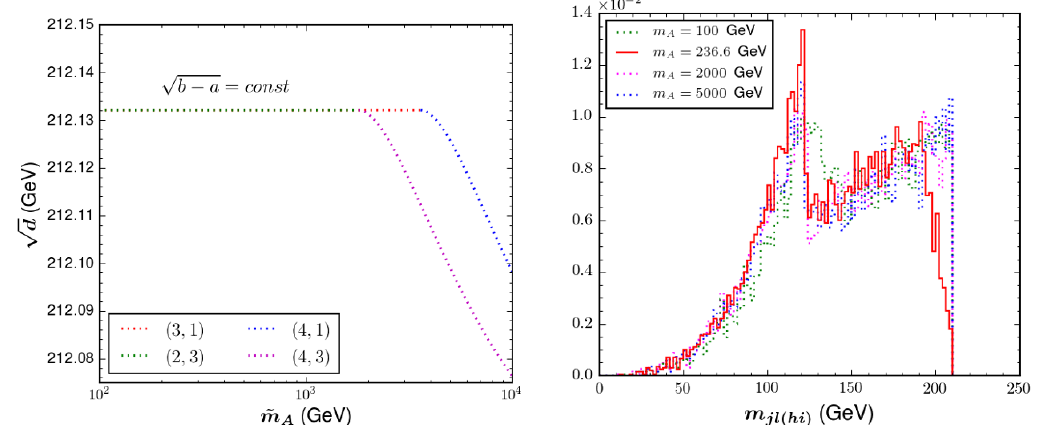
Figure 7 . Left: the prediction for the kinematic endpoint p d along the (cid:13)at direction (1.7) generated by P 31 , as a function of the trial value of the parameter ~ m A . Right: the same as (cid:12)gure 6, but for the distribution m . j‘ (hi)